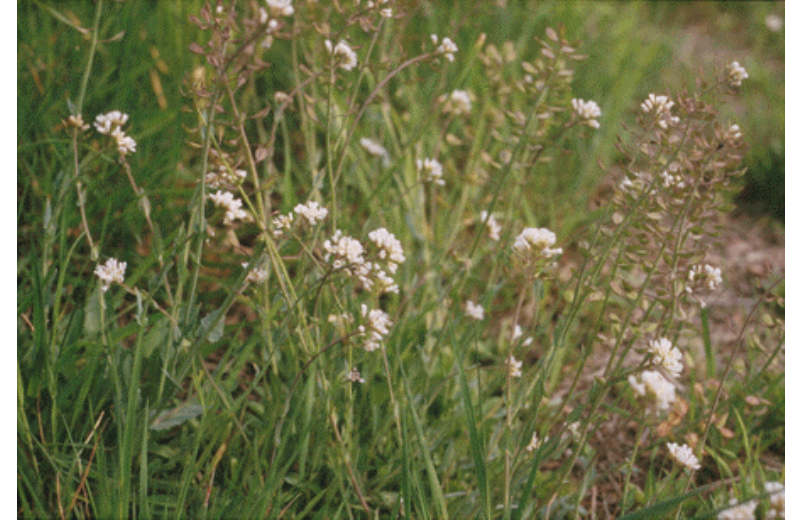
FIGURE 1. Thlaspi caerulescens (pennycress) on an old zinc/lead mine site in Plombières